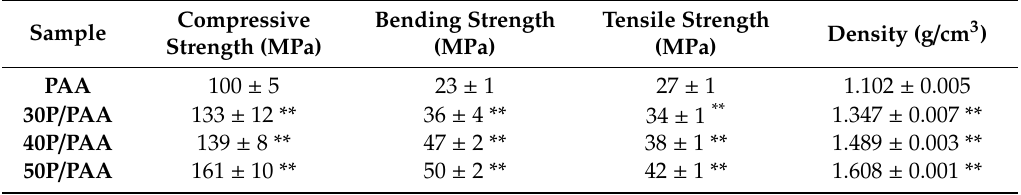
Table 2. Mechanical properties of P / PAA composites with di ff erent pearl powder contents. ** Significant di ff erence compared with PAA ( p <